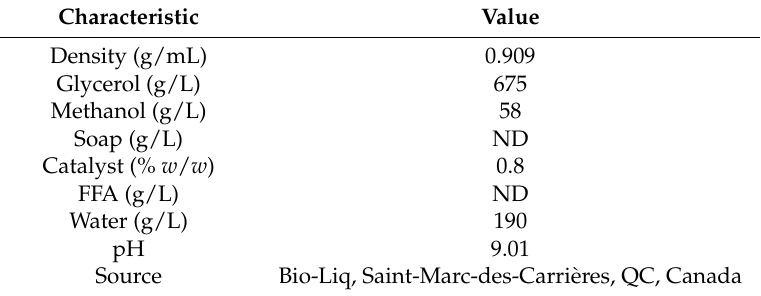
Table 2. Composition of crude